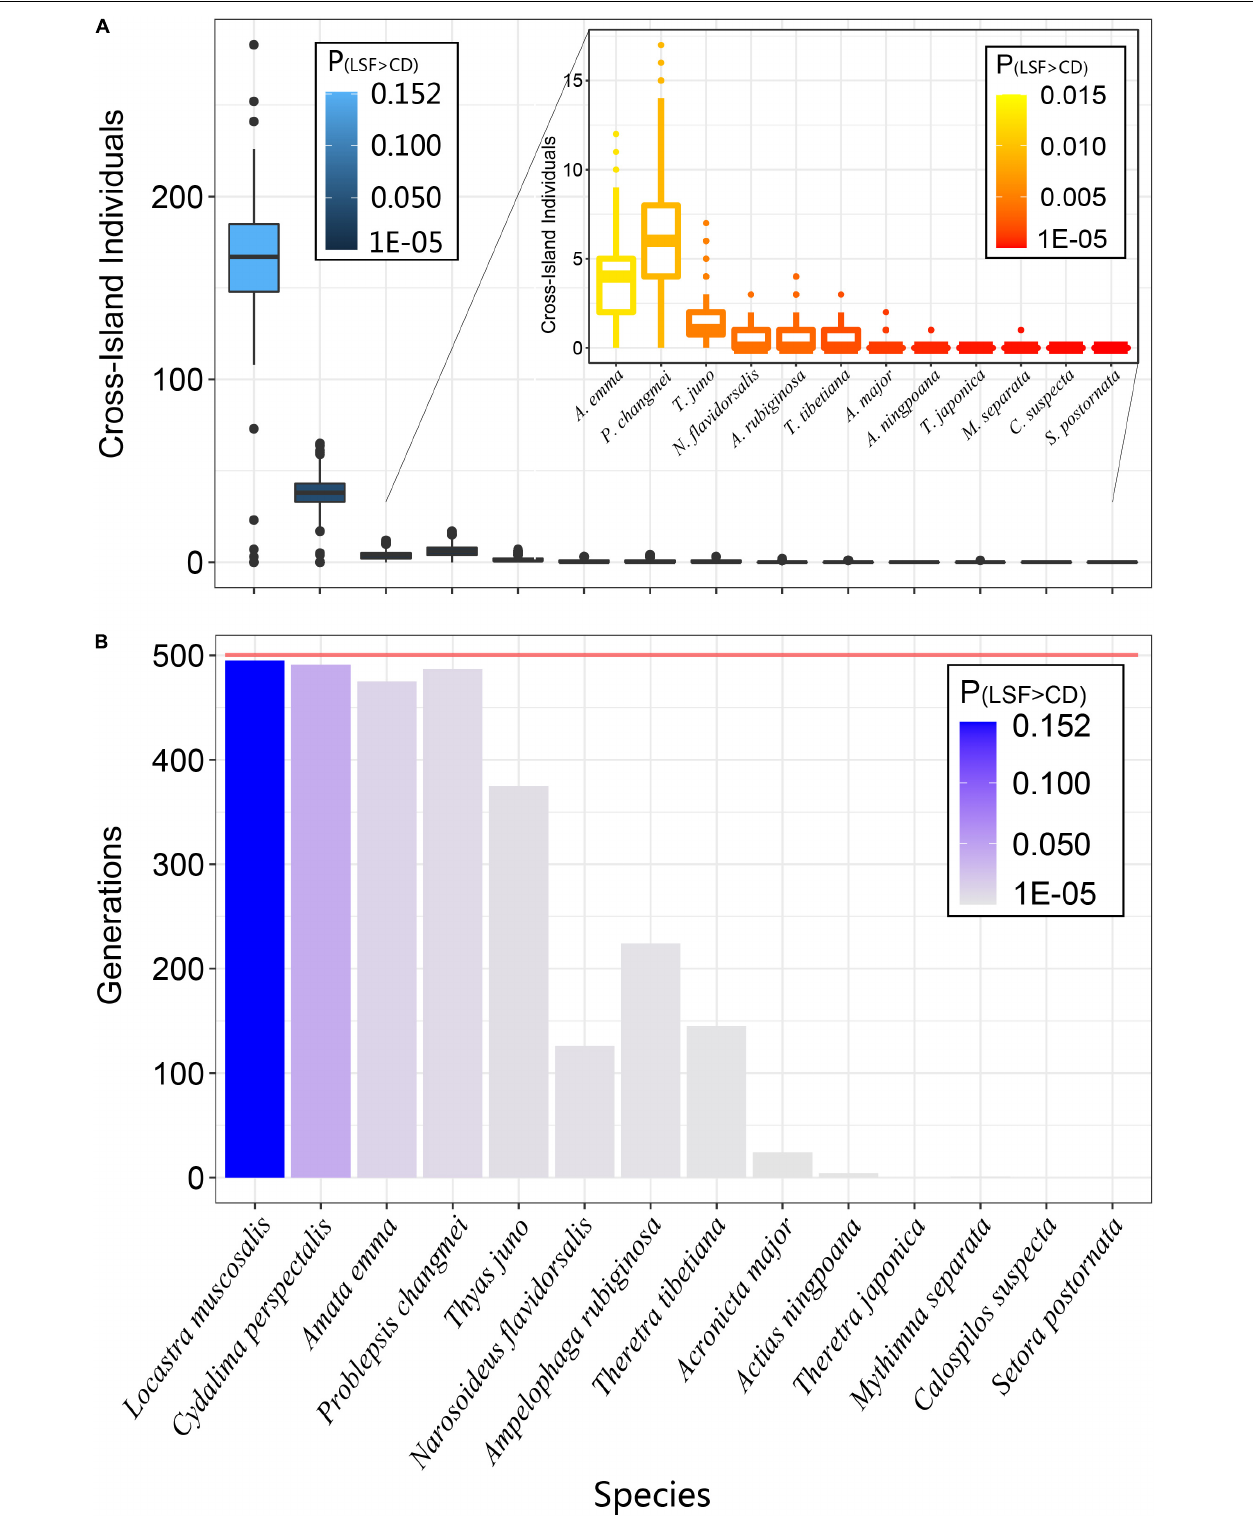
FIGURE 4 | The average number of individuals with different LSF levels of species dispersal from the mainland to island (A) and the number of generations (B) within 500 generations. LSF, longest single flight. P ( LSF > CD ) refers to the proportion of individuals with LSF greater than the CD between the two islands in the offspring of a species in the total